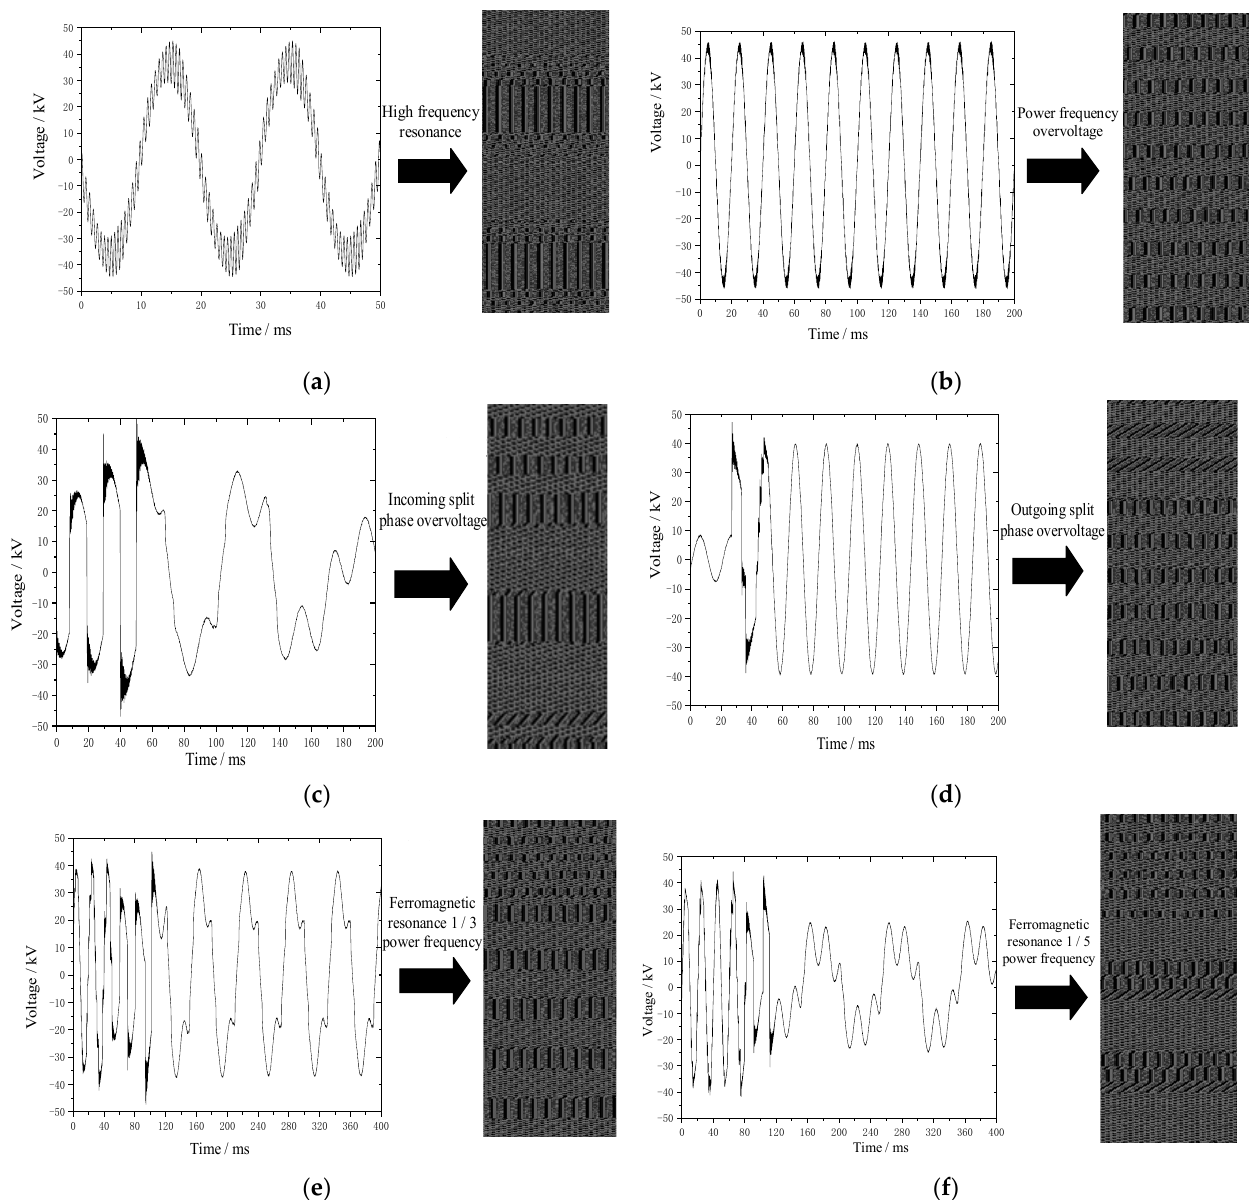
Figure 12. Overvoltage waveforms and their corresponding grayscale images: ( a ) high-frequency resonance overvoltage; ( b ) power frequency overvoltage; ( c ) entering neutral section overvoltage; ( d ) out neutral section overvoltage; ( e ) ferroresonant overvoltage (1/3 power frequency); ( f ) ferroresonant overvoltage (1/5 power frequency).